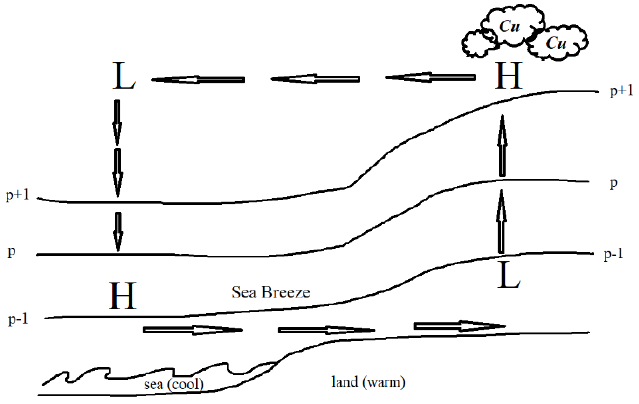
Figure 1. Sea breeze circulation.